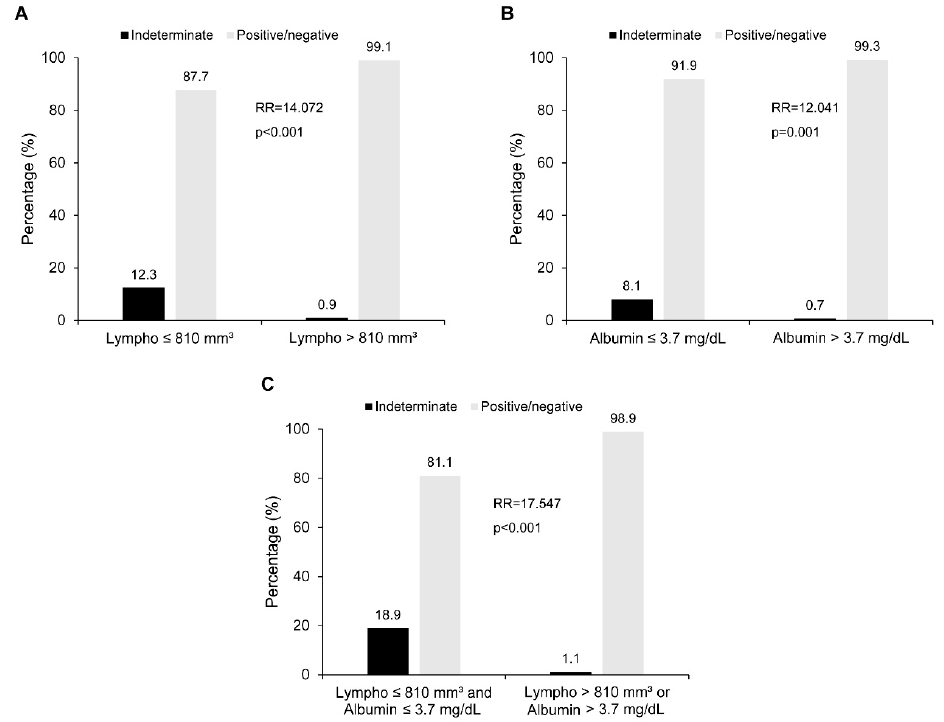
Figure 3. Relative risk of indeterminate results according to lymphocyte count and albumin level. Patients with ( A ) a lymphocyte count of ≤ 810 mm 3 and ( B ) an albumin level of ≤ 3.7 mg/dL had a significantly higher risk of indeterminate results being reported than those who did not meet these criteria. In addition, the RR increased in those with both ( C ) a lymphocyte count of ≤ 810 mm 3 and an albumin level of ≤ 3.7 mg/dL. RR: relative risk.